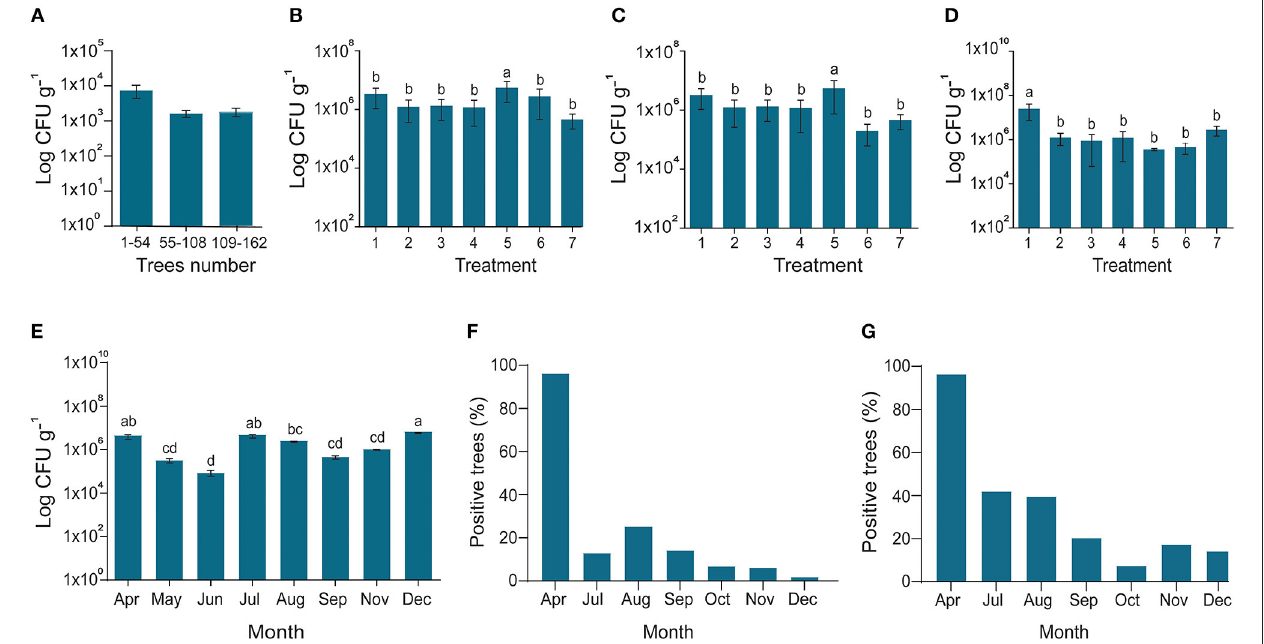
FIGURE 4 | Endophytes density and reduction of C Las pathogen. (A) In March 2017, the diseased citrus trees were checked for possible assessment endophyte before starting experiment; (B) In April 2017, all the trees treated with fertilizer 1 with Bacillus amyloliquefaciens Y2; the X-axis represents endophytes and penicillin injection through the trunk (1); endophyte injection (2); Penicillin spray (3); Endophyte spray (4); Penicillin injection (5); Control CK1 and CK2 (6,7); (C) Fertilizer 2 with B. amyloliquefaciens Y2; CK2 and CK3 (6,7); (D) No organic fertilizer (F 0 ) was used as control; (6,7) indigenous endophytes showing increase in the number of endophytes due to dispersal of endophytes in all the trees even control samples; (E) Endophytes population during different sampling times along with; and (F) Successive reduction of C Las pathogen inside disease trees using conventional PCR and (G) Nested PCR. The populations of endophytic bacteria were calculated based on the average logarithm (base 10) of bacteria recovered from the plant leaves. The log cfu values were analyzed with the GraphPad Prism version 8 (San Diego, California, USA). The values are means ± SD with statistically significant difference among different treatments with different letters ( p ≤ 0.05).